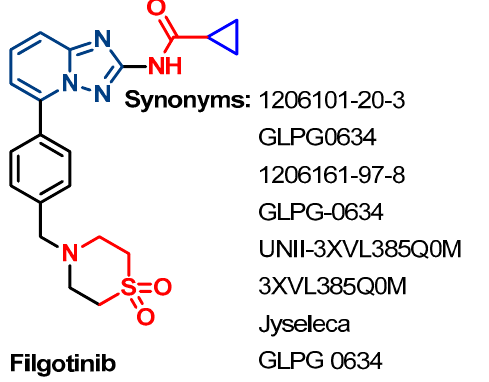
Figure 32. Chemical structure/name/synonyms of filgotinib.